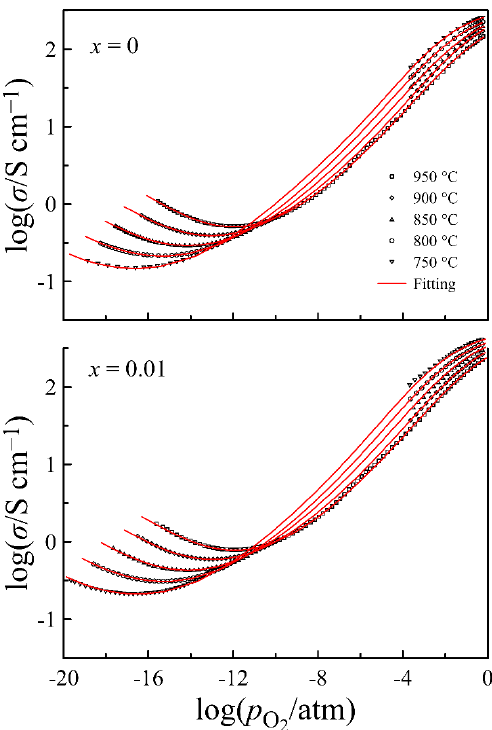
Figure 11. Electrical conductivity of La 0.5 − x Sr 0.5 FeO 3 − δ ( x = 0 and 0.01) as a function of oxygen partial pressure at different temperatures. Solid lines represent the results of Eq.